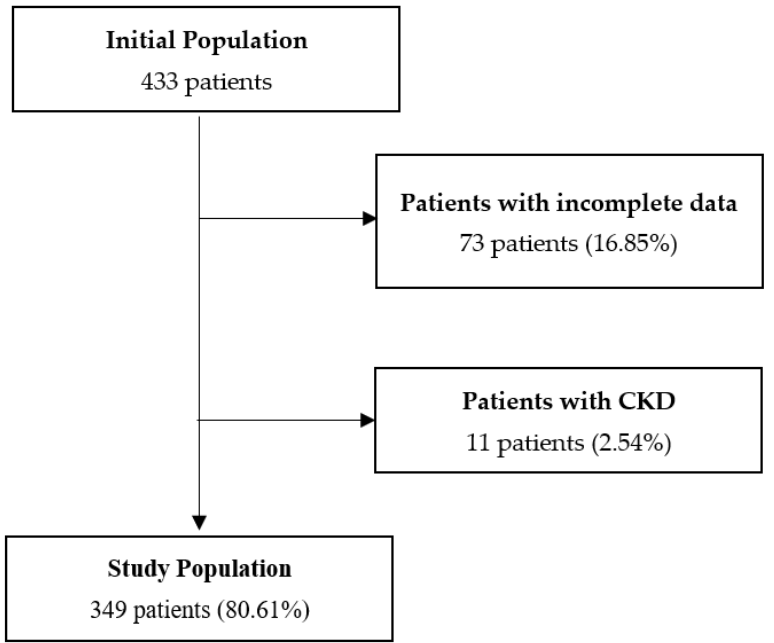
Figure 1. Patient selection flowchart.